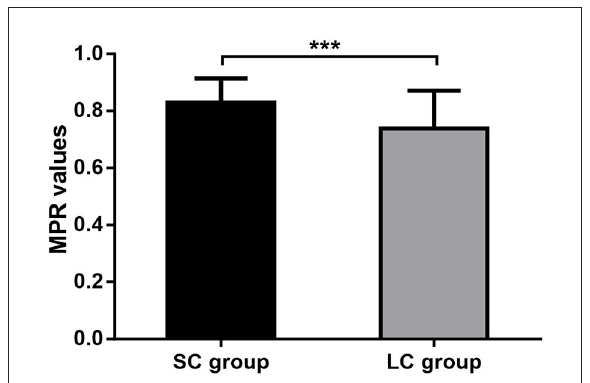
FIGURE5 Medication adherence. MPR, medication possession ratio; SC, short-course; LC, long-course; *** P < 0.001.